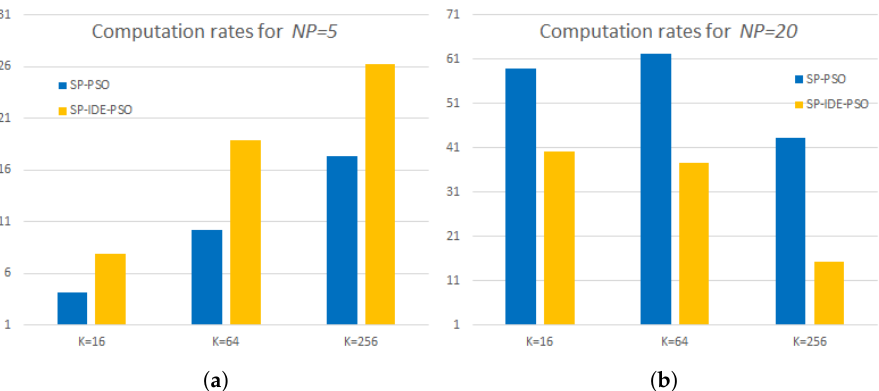
Figure 5. Computation rates of both superpixel CIQ methods for two swarm sizes. ( a ) NP = 5. ( b ) NP =